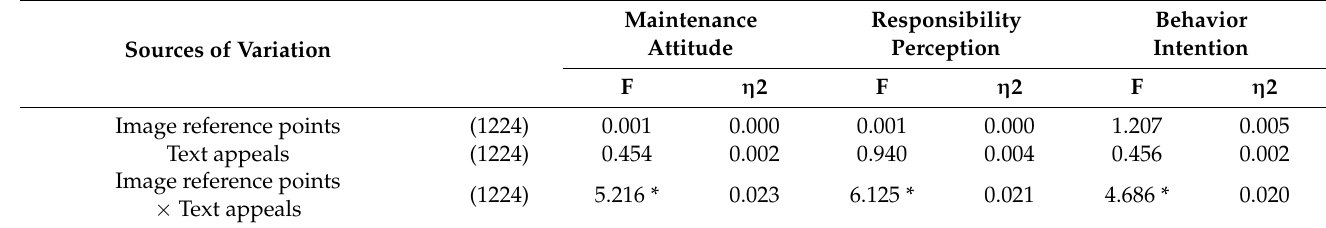
Table 1. Effects on maintenance attitudes, responsibility, and behavioral